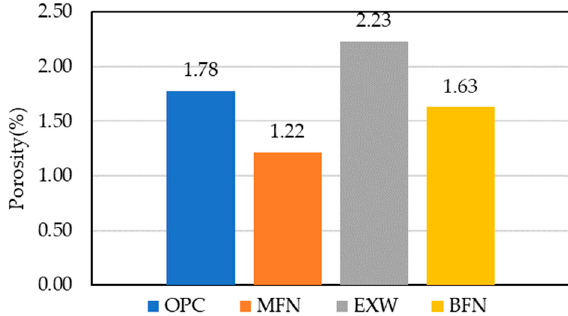
Figure 13. Percentage porosity of the mortar at 28 days.